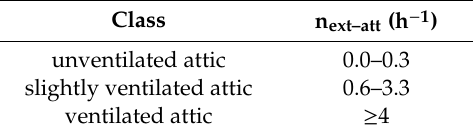
Table 4. Classes of the exterior–attic air change